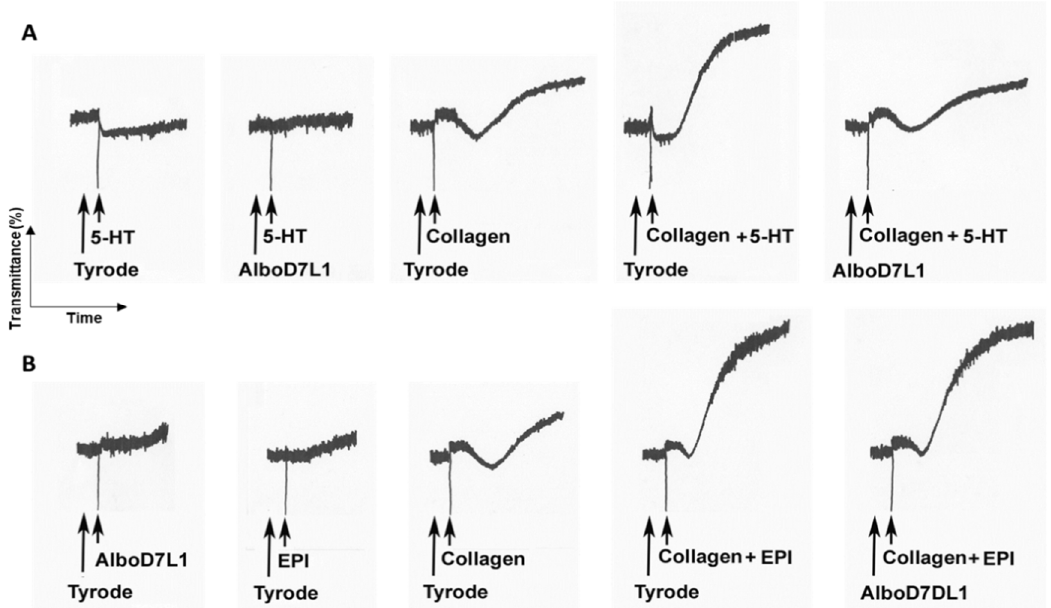
Figure 6. AlboD7L1 inhibits pro-aggregatory effects of serotonin, but not epinephrine. ( A ) AlboD7L1 inhibits 5-HT-induced shape change and 5-HT-induced potentiation of platelet aggregation triggered by collagen. Platelets were incubated with Tyrode (vehicle) or AlboD7L1 (1 µM), followed by the addition of serotonin (5-HT, 0.8 µM) alone or plus collagen (0.75 µg/mL), as indicated. From left to right , traces show shape change with 5-HT alone, inhibition of 5-HT-induced shape change in the presence of AlboD7L1, potentiation of the collagen response by co-addition of 5-HT resulting in a full aggregation response, and loss of potentiation by 5-HT in the presence of AlboD7L1. ( B ) AlboD7L1 does not inhibit epinephrine-mediated potentiation of platelet aggregation induced by collagen. Platelets were incubated with Tyrode (vehicle) or AlboD7L1 (1 µM), followed by the addition of epinephrine (EPI 0.8 µM) plus collagen (0.75 µg/mL), as indicated. From left to right , traces show no response of platelets to AlboD7L1 and epinephrine, shape change induced by collagen alone, potentiation of the collagen response by co-addition of epinephrine resulting in a full aggregation response, and no loss of potentiation by epinephrine in the presence of AlboD7L1. A Chrono-Log aggregometer model 500-CA was used.